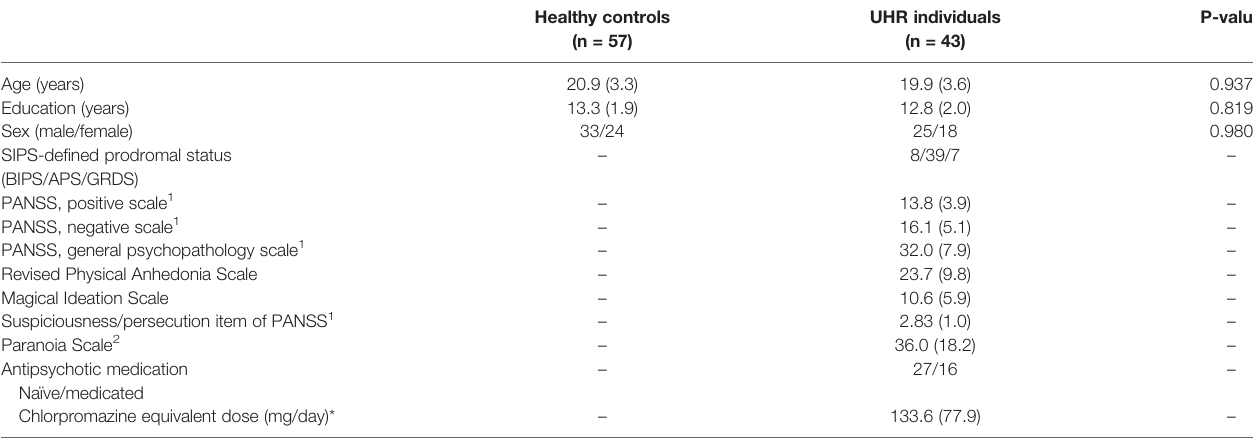
TABLE 1 | Demographic and clinical pro fi les of healthy controls and individuals at ultra-high risk for psychosis.